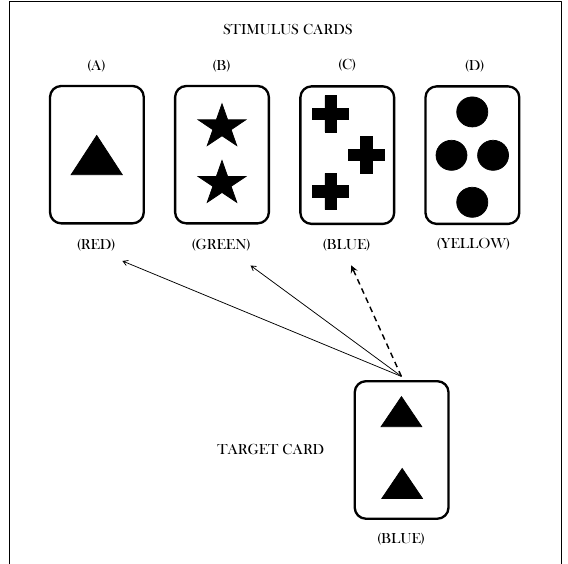
Figure 2. Example of a typical trial in the Wisconsin card sorting test. Arrows represent possible choices. In this example, the current sorting principle is color . Solid arrows, which sort the target card with stimulus cards (A) and (B), represent wrong matches. The dotted arrow, which sortes the target card with stimulus card (C), represents a right